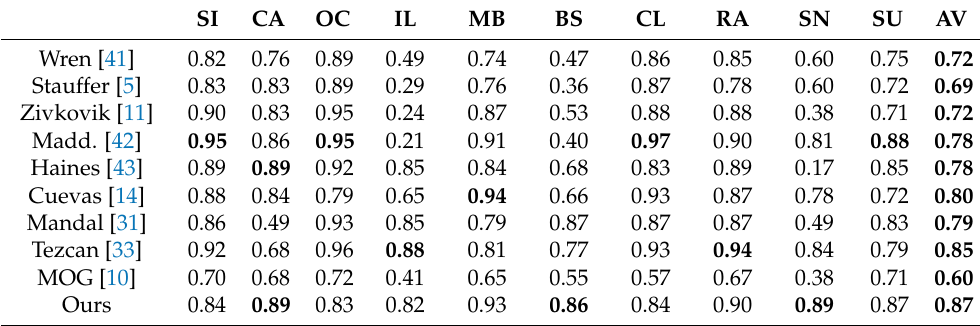
Table 4. Reported F-measures for the best methods published on LASIESTA’s official website. The last two rows correspond to the performances of the input to the mask refinement network (input mask in Figure 2) and the generated masks (output mask in the same Figure) with the network proposed. The results are given as final averages for all the sequences in the database (last column), and independently for each of the categories in the